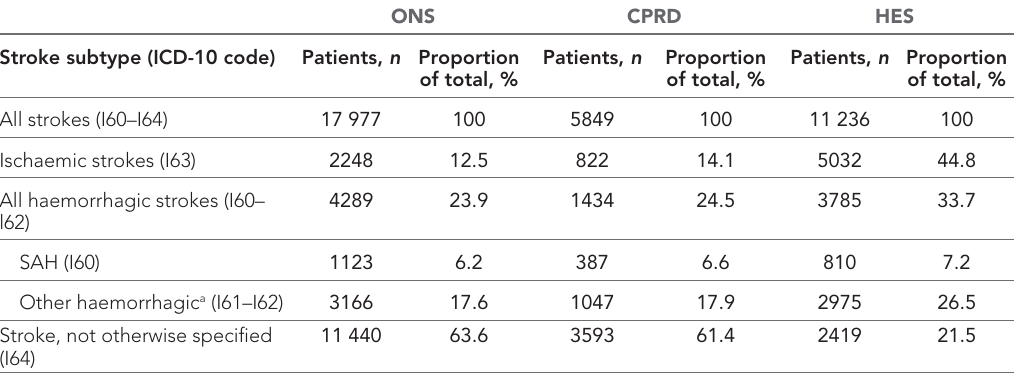
Table 3 Number of study- eligible fatal strokes recorded in ONS, CPRD, and HES data sources ONS CPRD HES Stroke subtype (ICD-10